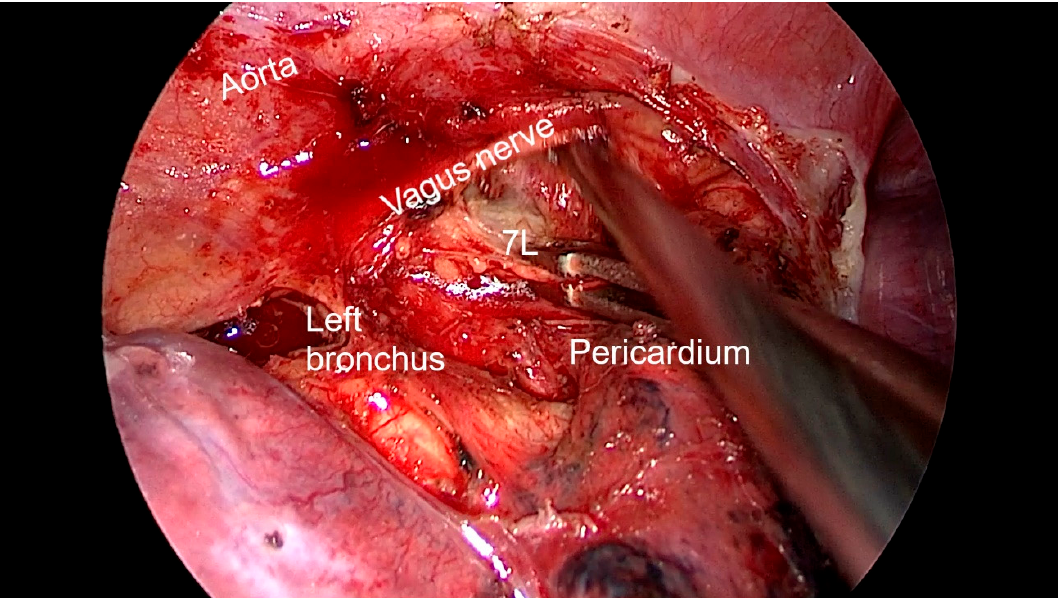
Figure 11. Anatomic landmarks during left subcarinal lymph node dissection (7L).